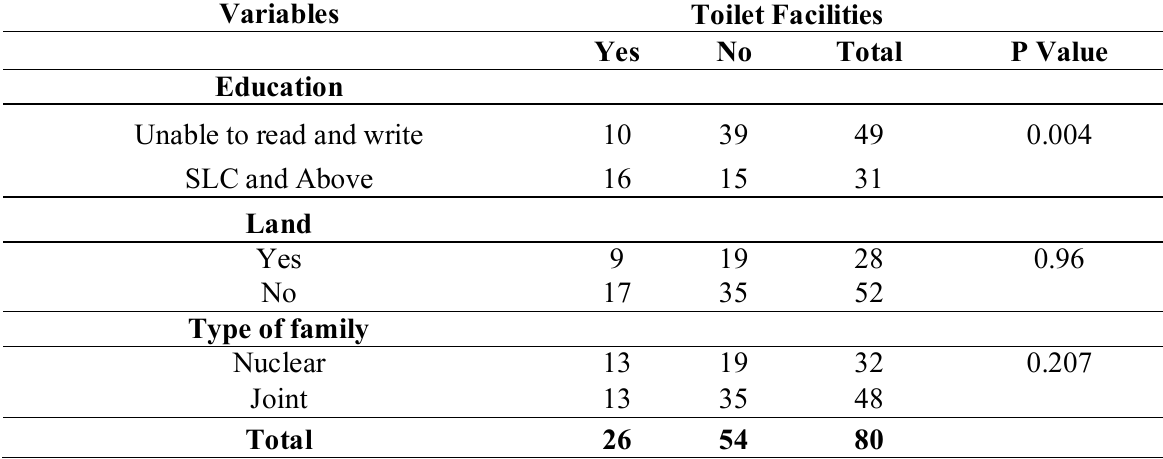
Table 3. Association of toilet facilities with different